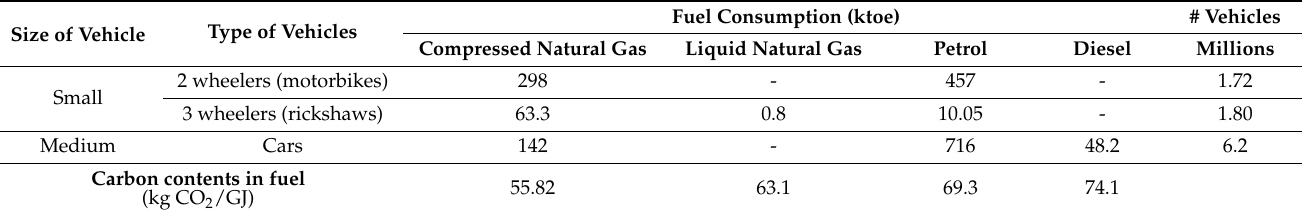
Table 2. Characteristics of the EVs involved in the current